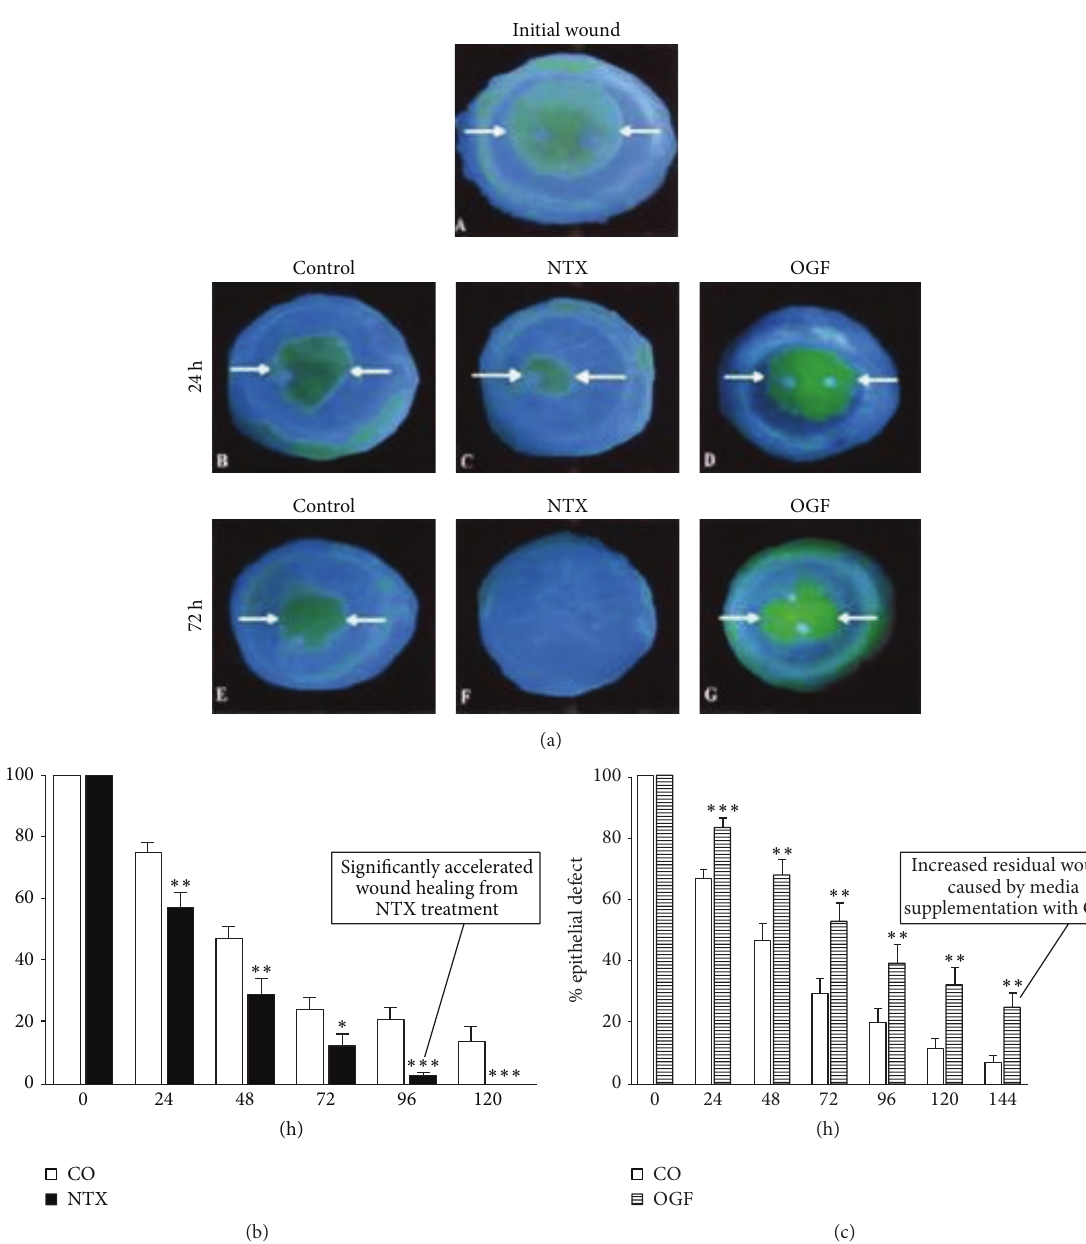
Figure 9: Human corneas in organ culture. (a) Photographs of abraded human corneas in organ culture at time of initial wounding and 24 and 72 hrs after wounding. Media supplemented with either sterile water (control) (B, E), 10 −6 M NTX (C, F), or 10 −6 M OGF (D, G). Note the more rapid healing response in NTX supplemented medium, compared to control, and decreased rate of wound healing with OGF medium supplementation. Arrows indicate the margins of the residual wounds. (b) Histograms illustrate the accelerated rate of epithelial wound healing in response to NTX culture medium supplementation. Overall, the healing of epithelial wounded human corneas cultured in medium supplemented with 10 −6 M NTX was accelerated by 21% to 89% during the period of 24 to 96 hours. (c) Supplementation of culture medium with OGF suppresses epithelial wound healing. Histogram of residual epithelial defect in organ cultured human corneas following 8 mmepithelial wounds. Medium was supplemented with either sterilewater (CO)or 10 −6 MOGF. 24% to260% moredefects presentin OGF- treated corneas at day 7. Data are expressed as means ± SEM. Significantly different from controls at ∗ 𝑃 < 0.05 , ∗∗ 𝑃 < 0.01 , or ∗∗∗ 𝑃 < 0.001 (derived from